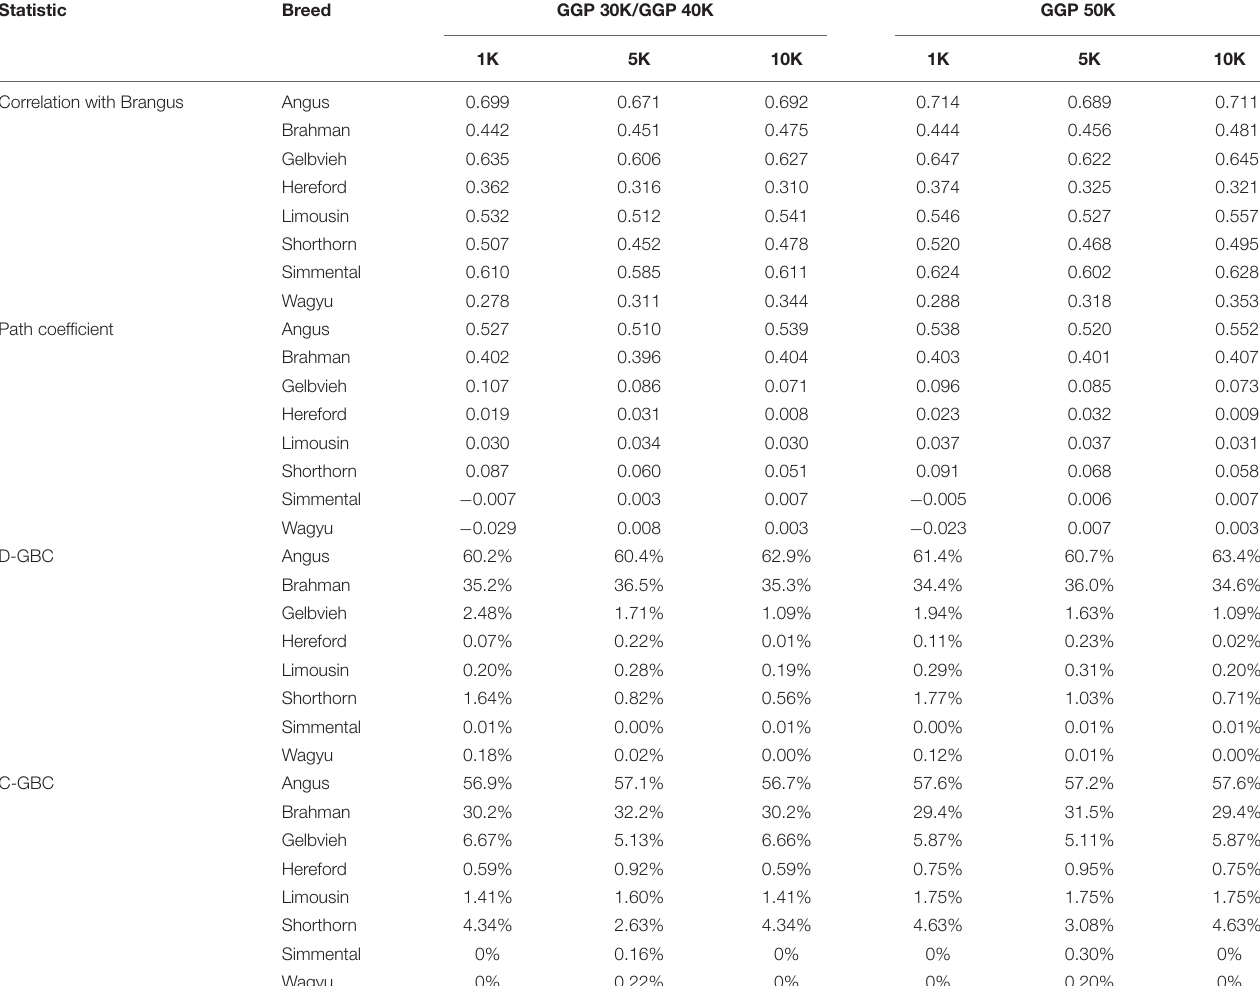
TABLE 2 | Path analysis using the correlation data for 7,969 Brangus animals with eight reference breeds and three SNP panels (1K, 5K, and 10K). Statistic